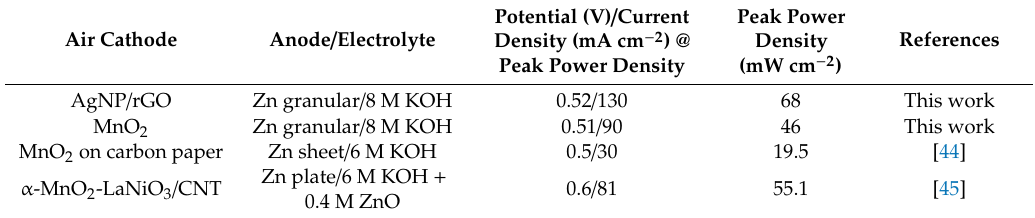
Table 2. Comparison of the battery that used the synthesized catalyst (0.3 M AgNP / rGO) and other zinc–air batteries previously reported.